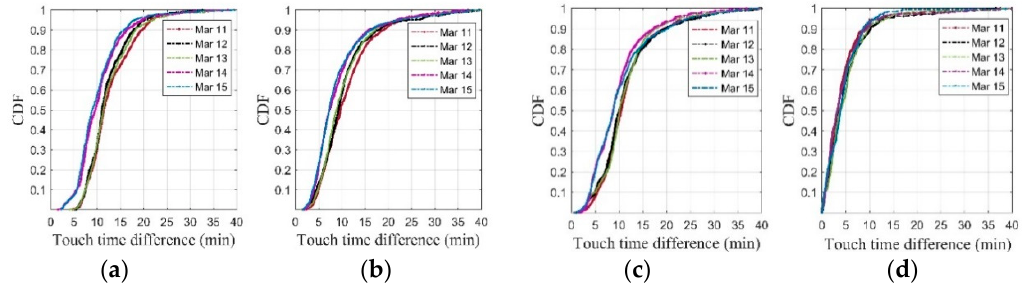
Figure 6. The cumulative distribution function (CDF) of metro-to-bus transaction time interval at four stations at 7:00–9:00 on 11–15 March. ( a ) Guomao station. ( b ) Shenzhen University station. ( c ) Daxin station. ( d ) Airport East station.